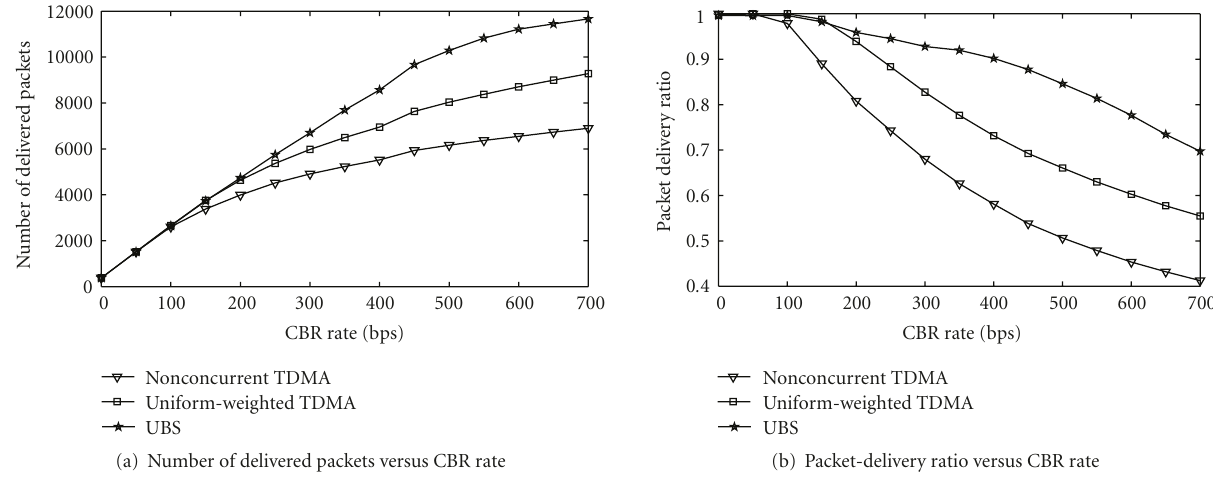
Figure 5: Simulation results with uniform tra ffi c scenarios averaged over 10 di ff erent 20-node network topologies.